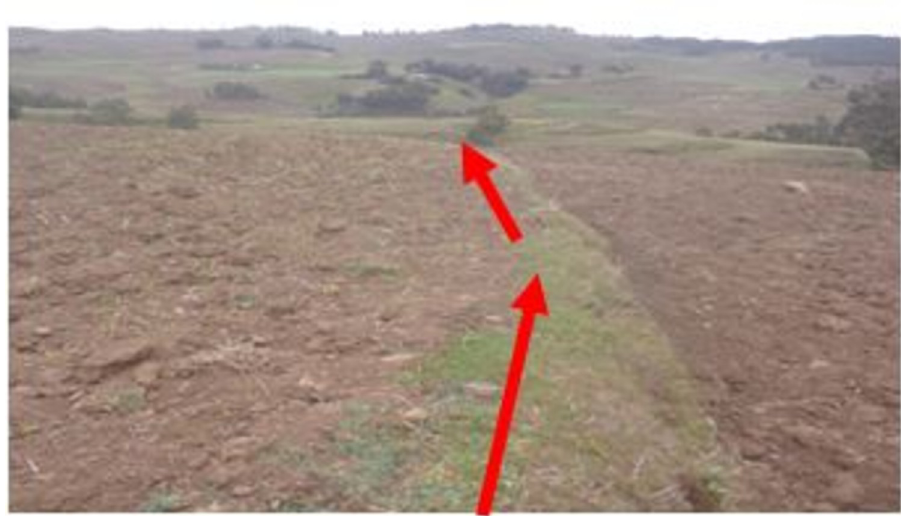
Fig 2. Up-graded soil bund in study